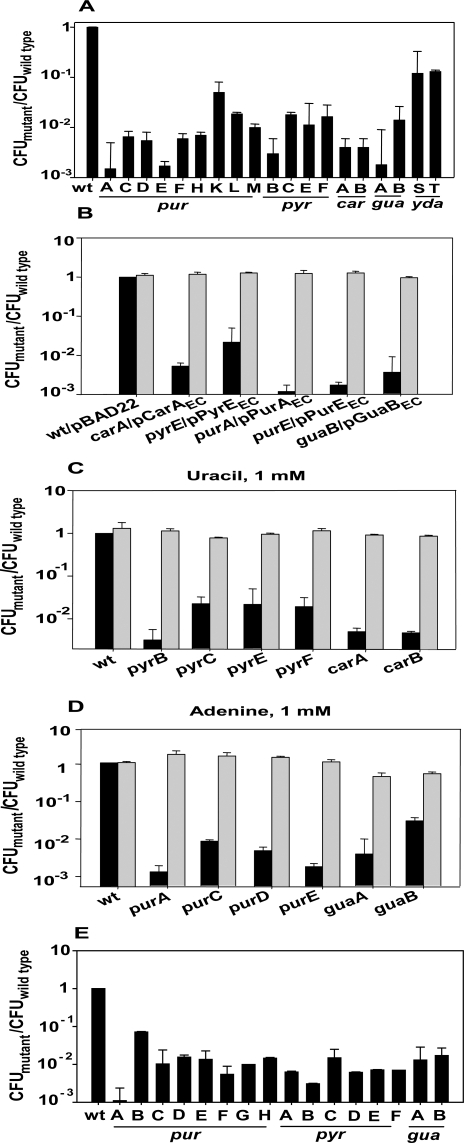

E. coli and S. typhimurium pur and pyr Mutants Have a Growth Defect in Human Serum(A) Ratios of the viable cell counts of 19 mutants identified by either MGK or MTT assay as compared to wild-type E. coli after 24 h of growth in human serum. p Values for each mutant relative to wild type were lower than 0.001.(B) Ratios of the viable cell counts of carA, pyrE, purA, purE and guaB mutants (black bars) and the viable cell counts of carA/pCarAEC, pyrE/pPyrEEC, purA/pPurAEC, purE/pPurEEC, guaB/pGuaBEC and wt+pBAD22 (grey bars) to those of wild-type E. coli following 24 h of growth in serum.(C) Grey bars represent ratios of the viable cell counts of each pyrimidine mutant to that of the wild-type E. coli after 24 h of growth in serum supplemented with 1 mM uracil. Black bars represent these ratios in serum without any nucleotide supplements.(D) Grey bars represent ratios of the viable cell counts of each purine mutant to that of the wild-type E. coli after 24 h of growth in serum supplemented with 1 mM adenine. Black bars represent these ratios in serum without any nucleotide supplements.(E) Ratios of the viable cell counts of Tn5 transposon insertion mutants in several pur and pyr genes of S. typhimurium to that of the wild type determined after 24 h of growth in human serum by plating serial dilutions on LB agar plates are represented by vertical bars. p Values for each mutant relative to wild type were lower than 0.01. Error bars indicate standard deviation (SD) for two independent experiments. Statistical significance of the data was calculated using t-test in EXCEL.